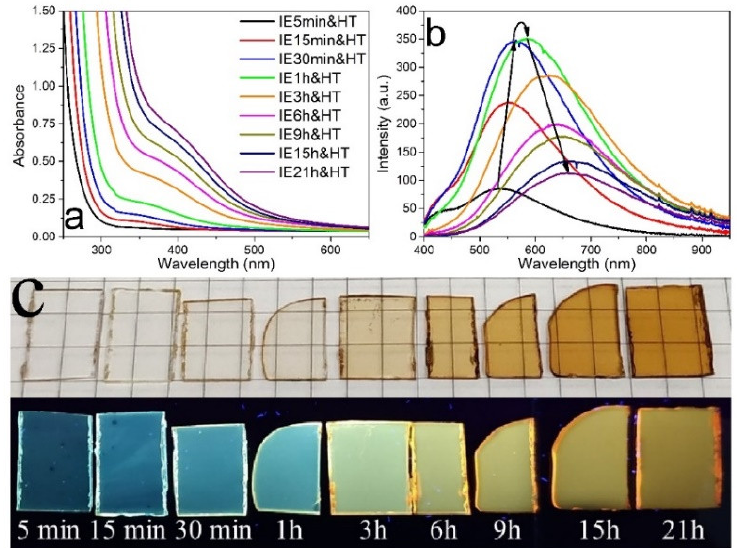
Figure 16. Absorbance ( a ) and emission ( b ) spectra of PTR-Sb2 glass samples ion-exchanged for different time and heat-treated at 450 °C for 15 h. The excitation wavelength was 350 nm. ( c ) Photo of the same samples in daylight ( top row ) and UV light ( bottom row ).